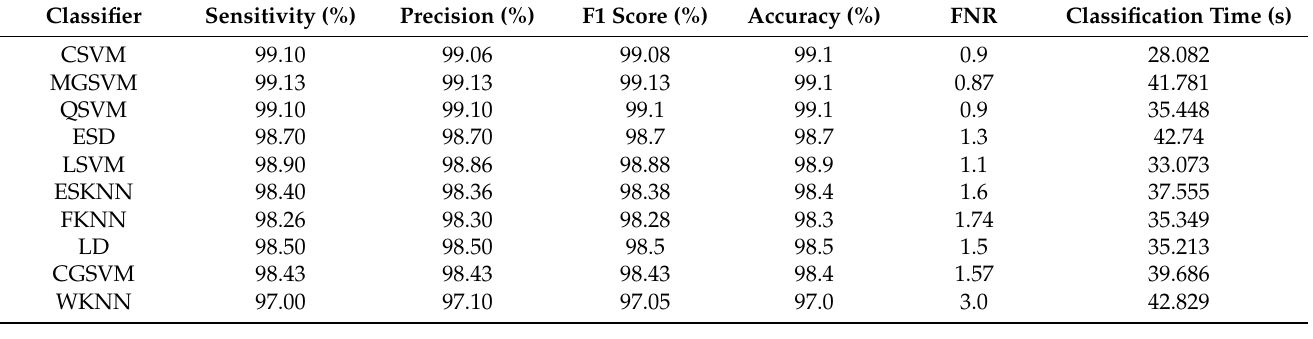
Table 5. Classification results of binary differential evolution selector using ultrasound images, where the training/testing ratio is 50:50.